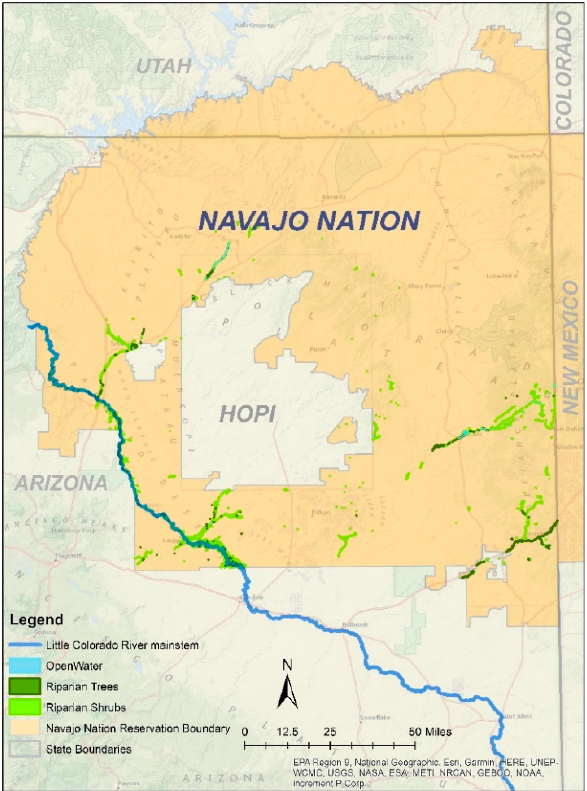
Figure 1. The study region of interest (ROI) is comprised of the riparian corridors along the Little Colorado River tributaries and streams in the Navajo